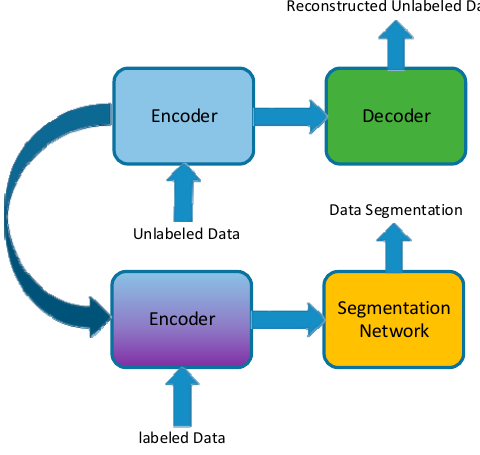
Figure 9. Proposed semi-supervised learning process. The information from the unlabeled data-trained AEN is used to supervise the labeled data-trained CNN process.